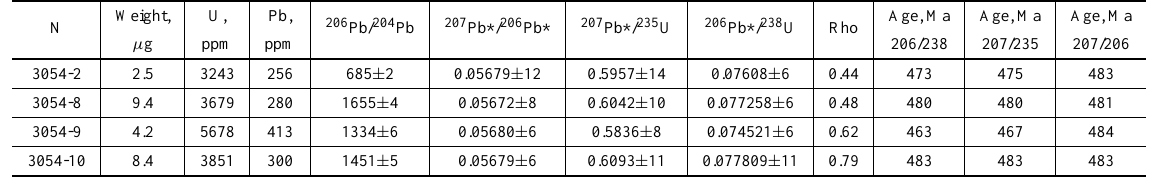
Results from U-Pb analyses of zircon 3054 of Nevsky granite massif, Khanka region, Far East, Russia.